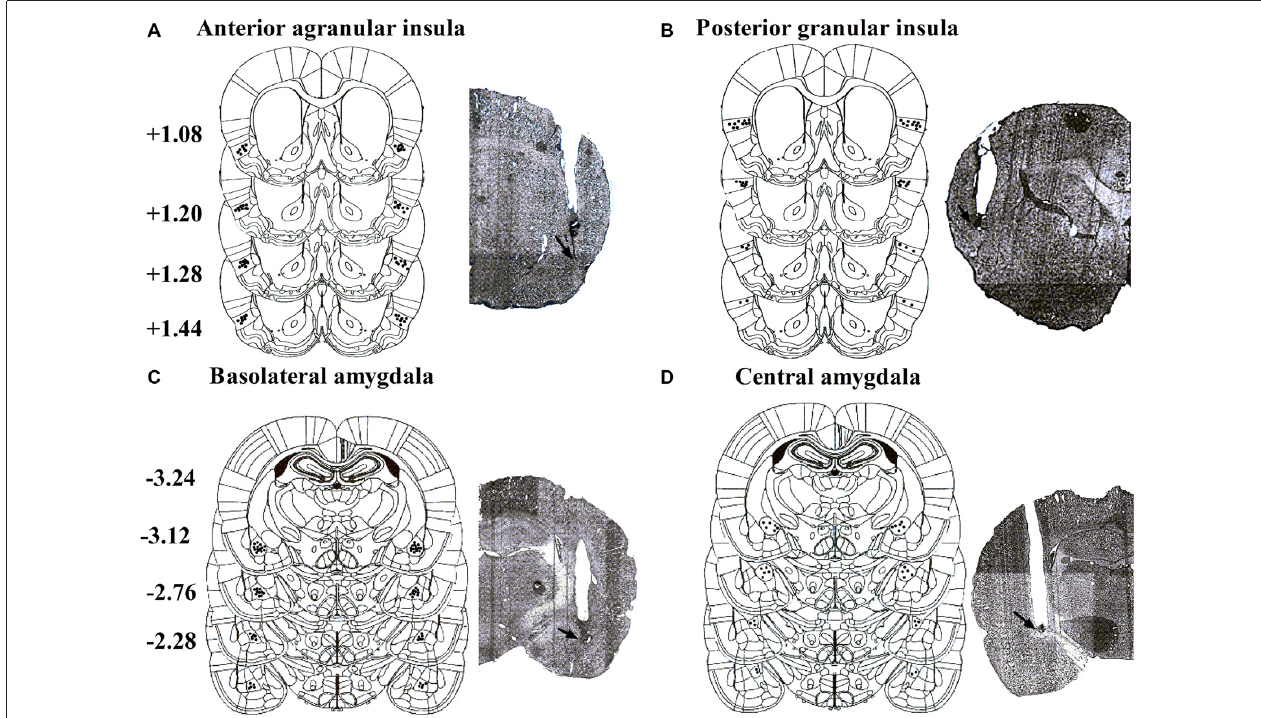
FIGURE 1 | Schematic illustrations and representative photomicrographs of the intracranial cannula infusion sites in the agranular insular (AI; A), granular insular (GI; B), basolateral amygdala (BLA; C) and central amygdala (CeA; D). Numbers besides the sections indicate anteroposterior distance from bregma in millimeters. Data are reconstructed from Paxinos and Watson (2007).